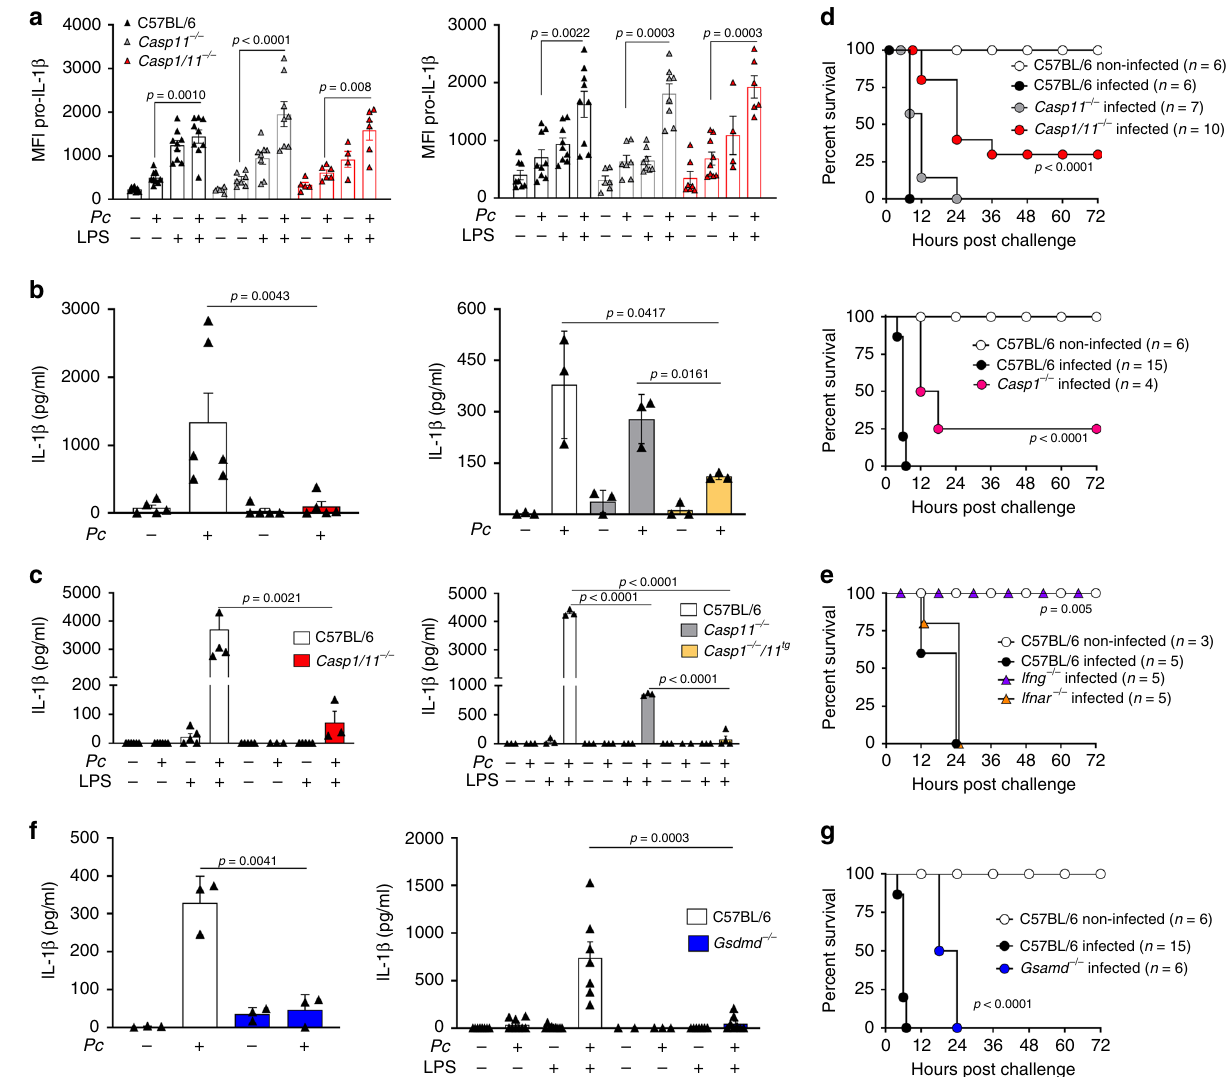
Fig. 2 Caspase-1-dependent release of IL-1 β in Pc -infected mice challenged with LPS. a Splenocytes were stimulated with 1 μ g/mL of LPS and used for intracellular pro-IL-1 β staining by fl ow cytometry. The pro-IL-1 β MFI quanti fi cation was assayed in live (live/dead − ) monocytes (CD11b + F4/80 + , left panel) and dendritic cells (CD11c + MHC II + , right panel). For MOs: C57BL/6 n = 9, Casp1/11 − / − (control n = 5, + LPS n = 4; infected n = 6), and Casp11 − / − (control n = 6, + LPS n = 8; infected n = 7, + LPS n = 8). For monocyte-derived dendritic cells (MO-DCs): C57BL/6 n = 9, Casp1/11 − / − (control n = 7, + LPS n = 4; infected n = 9, + LPS n = 6), and Casp11 − / − (control n = 6, + LPS n = 8; infected n = 7, + LPS n = 8). b Splenocytes were stimulated in vitro with 1 μ g/ml of LPS and 24 h later IL-1 β measured by ELISA in supernatants. Left panel: C57BL/6 (control n = 5, infected n = 6) and Casp1/11 − / − n = 5. Right panel: n = 3. c Mice were inoculated intravenously with 10 μ g/mice of LPS, and 8 h later, plasma was collected and circulating IL-1 β measured by ELISA. Left panel: C57BL/6 (non-challenged n = 6, LPS-challenged n = 5) and Casp1/11 − / − (non-challenged n = 5, LPS-challenged n = 3). Right panel: n = 3 for all groups, except Casp1 − / − /11 tg (infected n = 2; infected + LPS n = 4). d C57BL/6, Casp11 − / − , Casp1/11 − / − (top panel), as well as C57BL/6 and Casp1 − / − (bottom panel) were inoculated intravenously with 10 μ g/mouse of LPS, and survival followed for 72 h. e C57BL/6, Ifng − / − , and Ifnar − / − were inoculated intravenously with 10 μ g/mouse of LPS and survival followed for 72 h. f , left panel: Splenocytes were stimulated in vitro with LPS (1 μ g/ml) and IL-1 β measured by ELISA in 24 h supernatants. For all groups, n = 3. f , right panel: C57BL/6 and Gsdmd − / − mice were inoculated i.v. with 10 μ g/mouse of LPS and plasma collected to measure the levels of IL-1 β at 8 h post-challenge. C57BL/6 ( n = 9, except infected + LPS n = 7) and Gsdmd − / − (control n = 2 and control + LPS n = 7; infected n = 3 and infected + LPS n = 8). g C57BL/6 and Gsdmd − / − mice were challenged with 10 μ g/mouse of LPS and followed for survival. In a , b , c , and f , mean ± s.e.m of two-three different experiments are shown; statistical analysis by parametric or nonparametric t test and one-way ANOVA. Survival curves were analyzed by log-rank